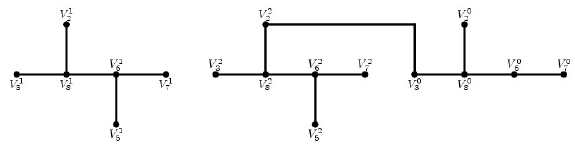
Figure 7. Subgraph of ][ 3 23